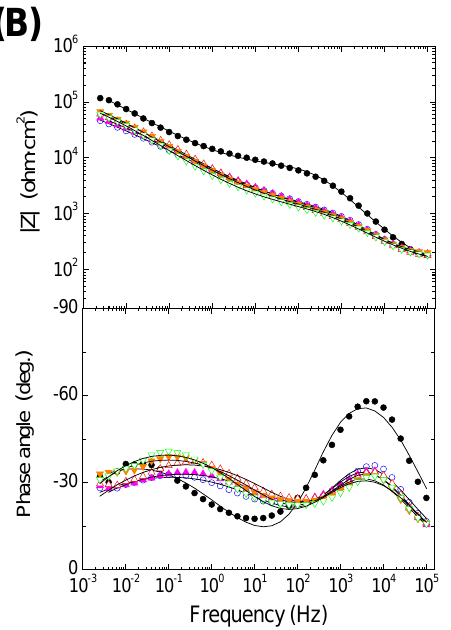
Figure 15. Evolution of the electrochemical impedance spectra with immersion time in SBF for HAp-coatings/Ti6Al4V system thermally treated at 800 ◦ C, 2 h.